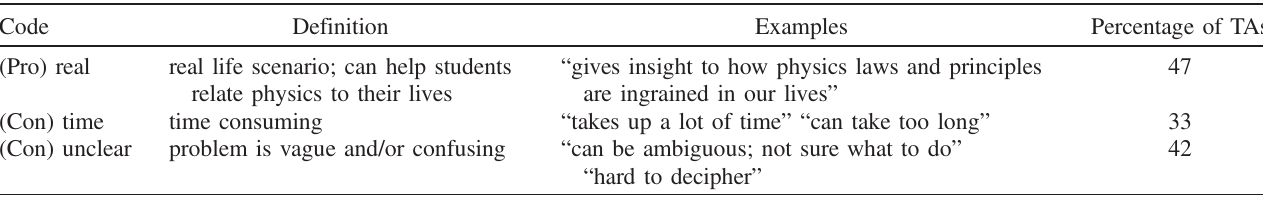
TABLE II. The most commonly listed pros or cons of the context-rich problem type and the percentages of TAs who listed them. Some TAs listed more than one of the following or other pros or cons not listed here. However, other pros were negligible and the overlap of the two cons listed below represents only 5% of all TAs.